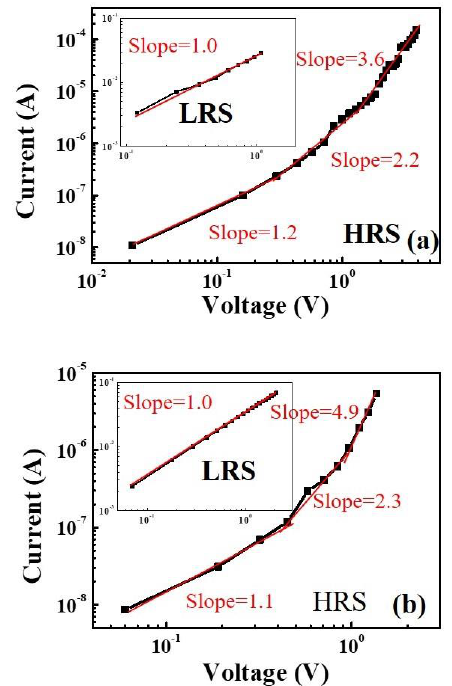
Figure 6. Log I –log V curves for the positive voltage regions and the negative voltage regions of: ( a ) Al / MZN / ITO device; and ( b ) Al / MZN NR / ITO device. The inset image shows the Log IV curves for the